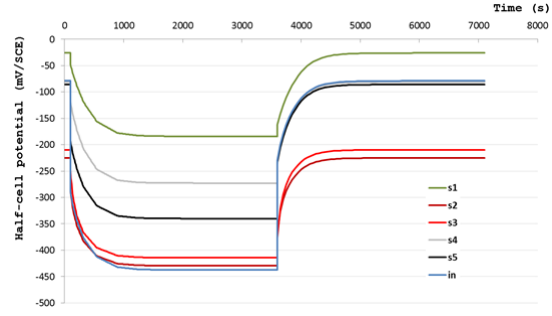
Figure 6. Numerical simulation of the ICCP experiment.